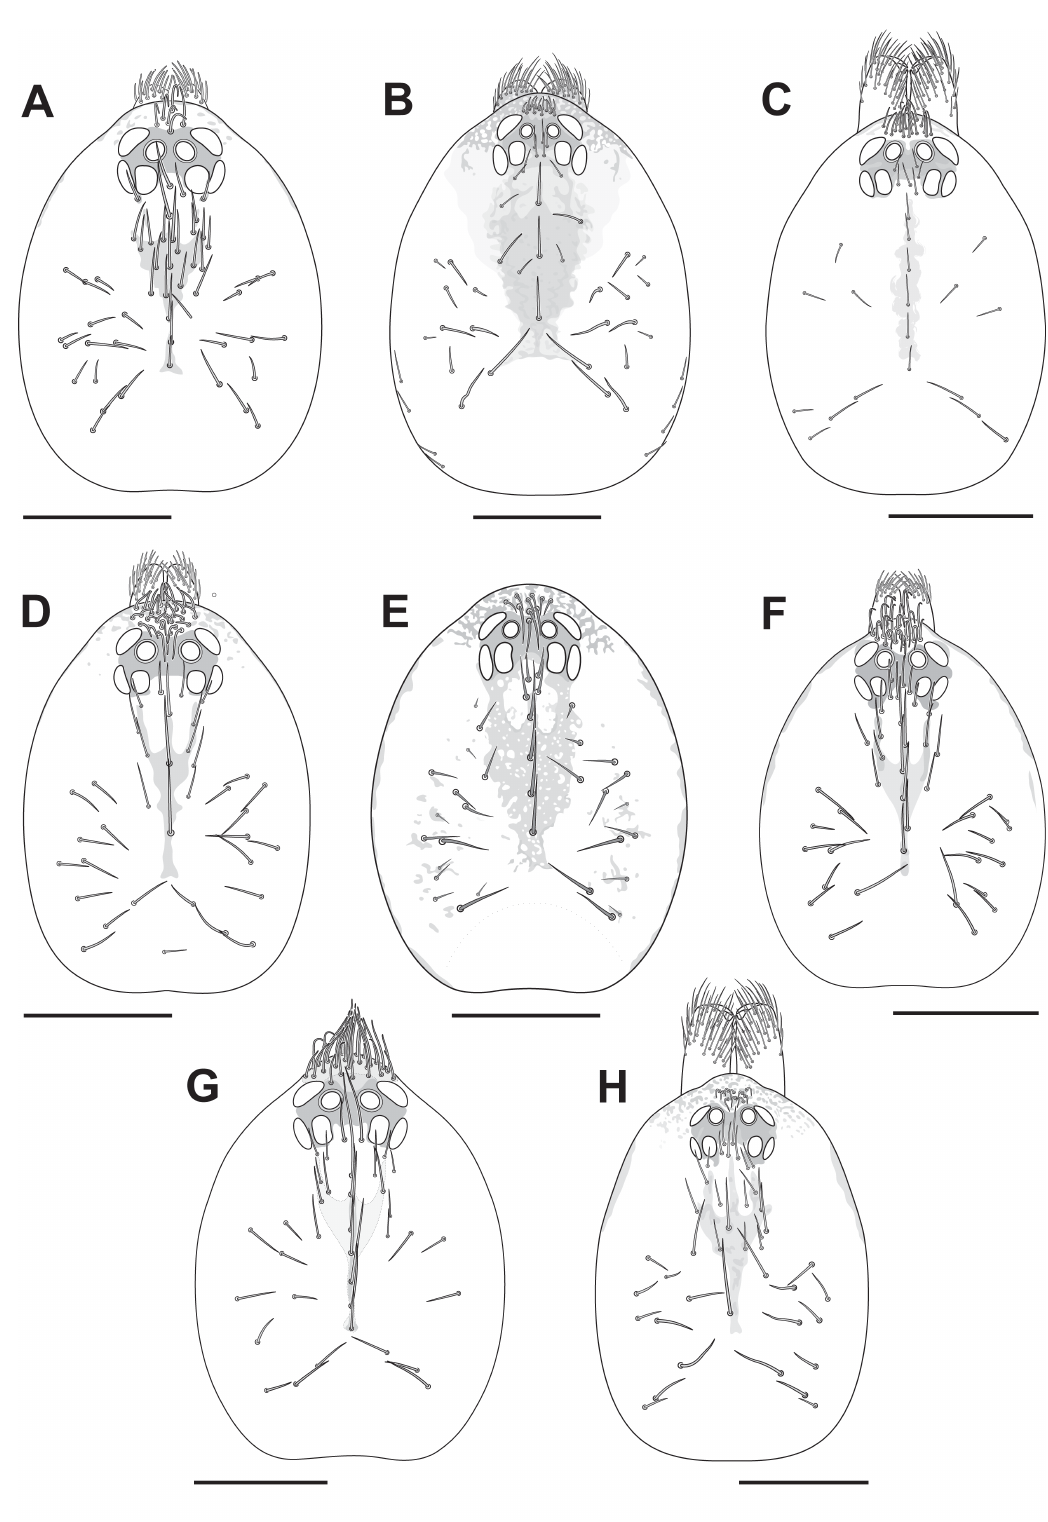
Fig. 42. Variations of coloration and setation of carapace in ♂♂ ( A , D , F–G ) and ♀♀ ( B–C , E , H ) of some Zaitunia species. — A–B . Z. logunovi sp. nov. C . Z. inderensis Ponomarev, 2005. D–E . Z. beshkentica (Andreeva & Tyshchenko, 1969). F . Zaitunia wunderlichi sp. nov. G–H . Z. maracandica (Charitonov, 1946). Scale bars = 0.5